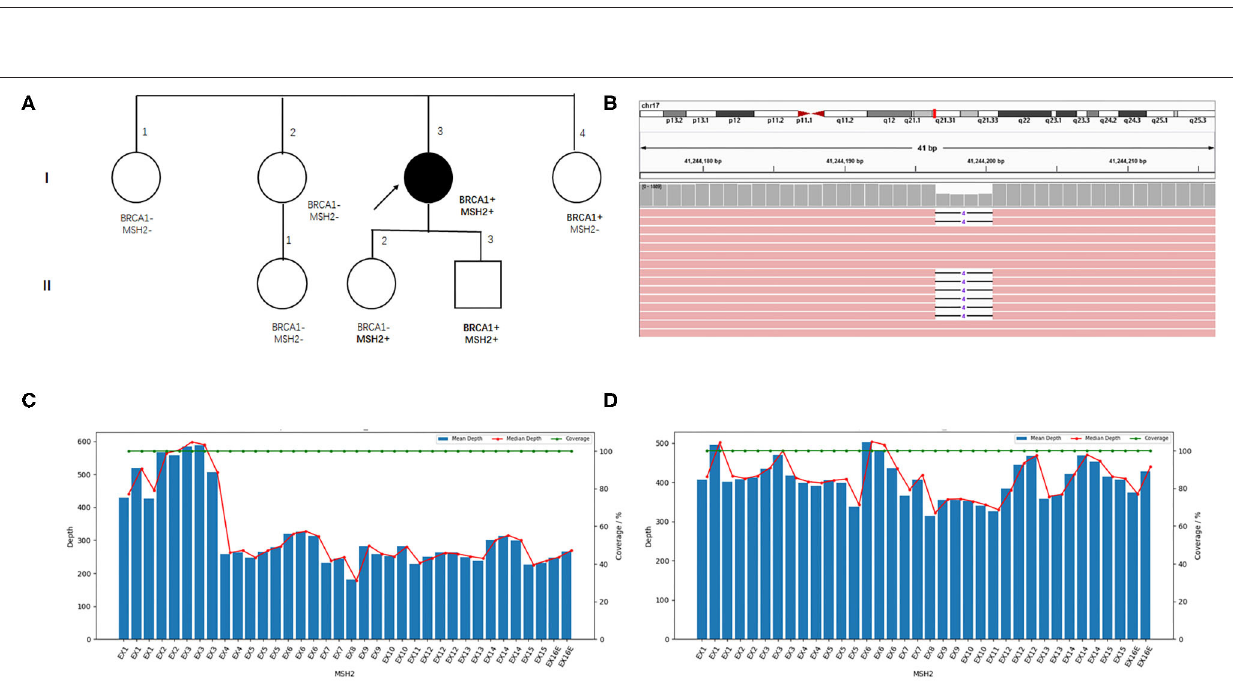
FIGURE 2 | Family pedigree and germline mutations identified in the index patient. (A) Family pedigree. The index patient is indicated with an arrow, and the circle filled with black color denotes endometrial cancer. (B) Visualized sequencing data shows the BRCA1 variant. MSH2 exons coverage depth analysis in the index patient (C) and another sample with the same batch (D)